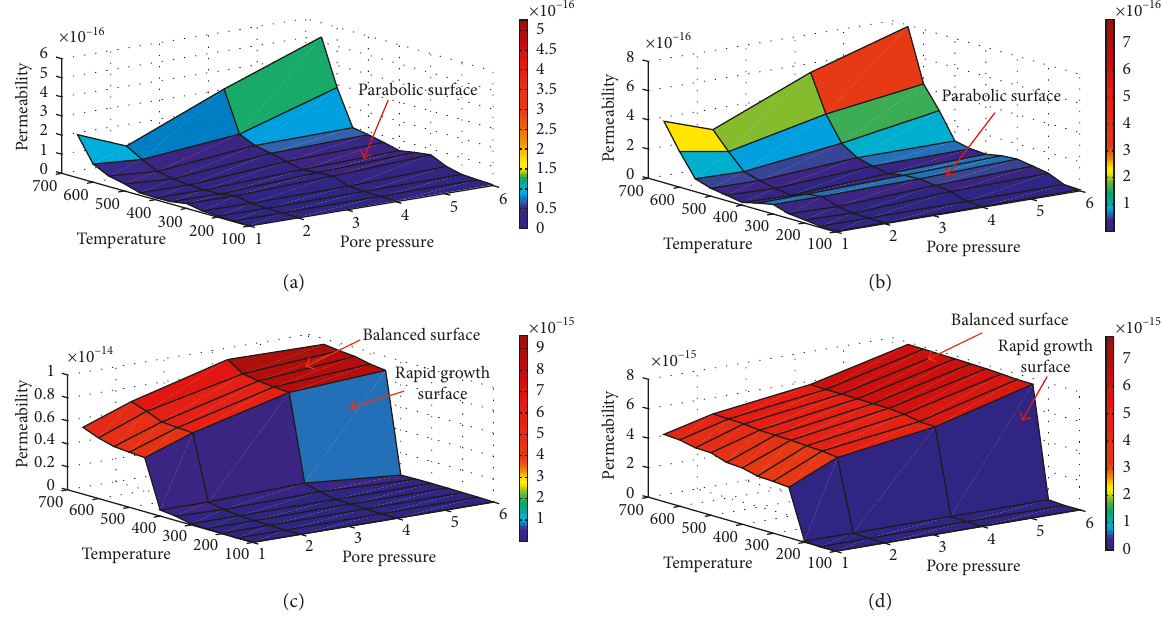
Figure 3: The permeability of granite specimen at different inlet gas pressures and temperatures. (a) The initial axial compression is 60% of UCS. (b) The initial axial compression is 70% of UCS. (c) The initial axial compression is 90% of UCS. (d) The initial axial compression is 90% of UCS. Table 1: Permeability analysis of granite specimen with the low initial damage. Samples The different initial